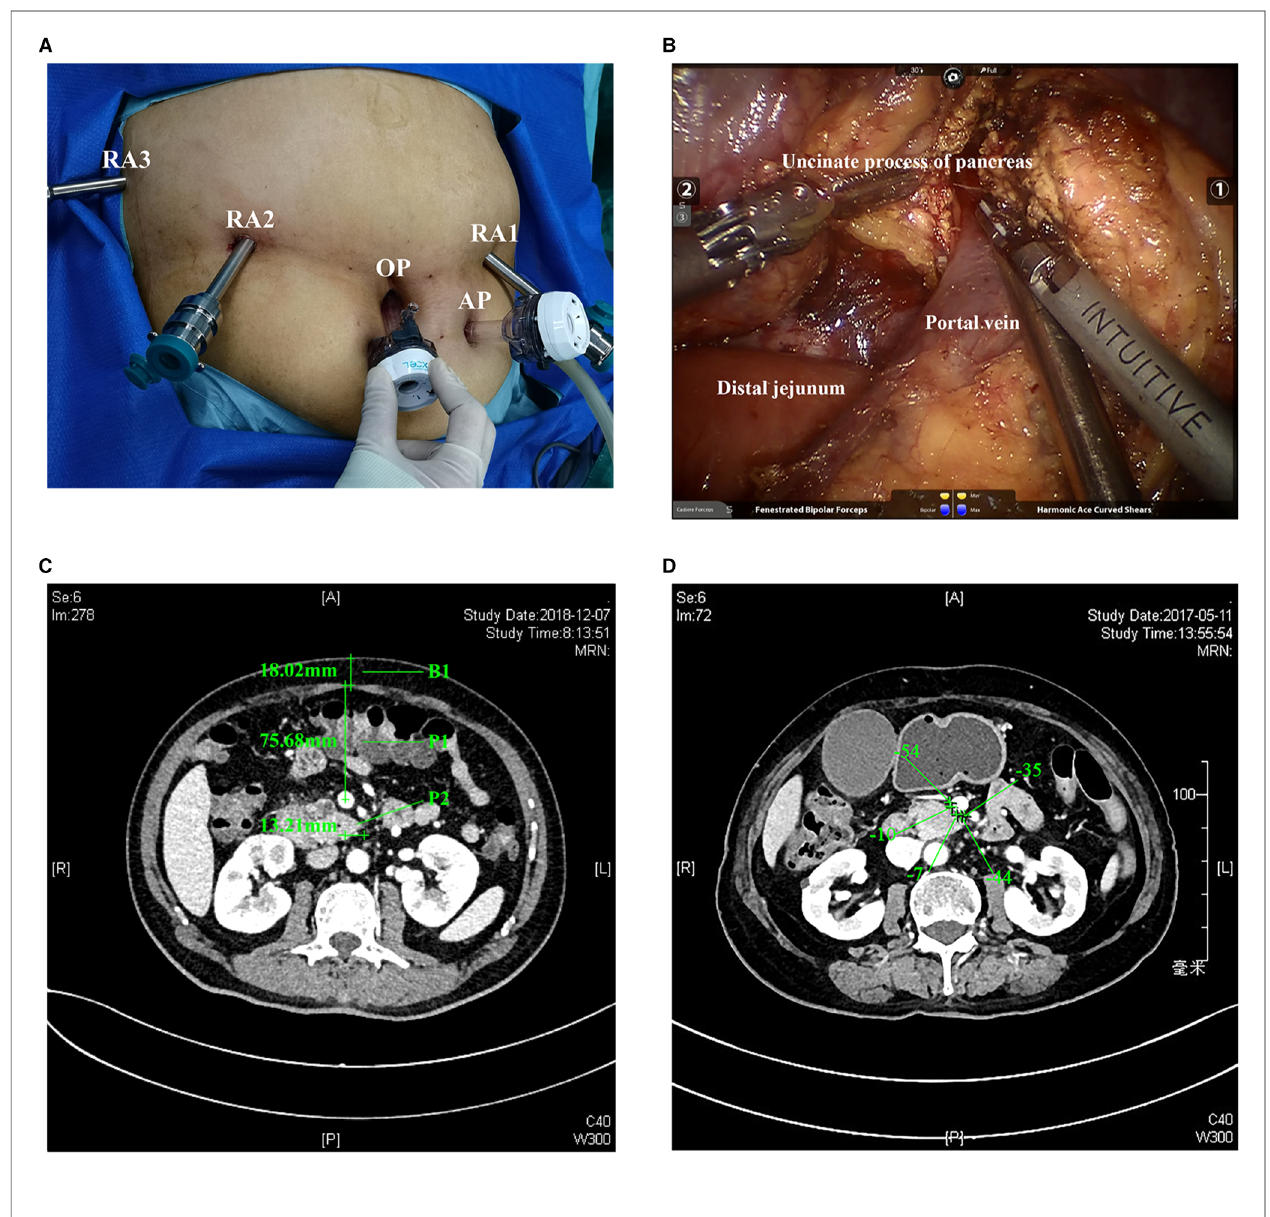
signs are located in the fi gure. The CT image is in the venous phase. CT, computed tomography; P1, mesenteric tissue thickness; P2, length of the uncinate process; B1, thickness of the abdominal